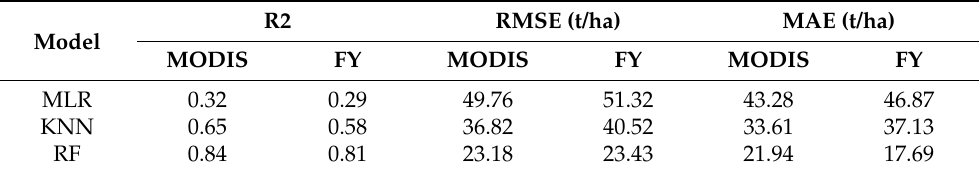
Table 4. Statistics for estimation of forest AGB using three approaches with the validation dataset (n =